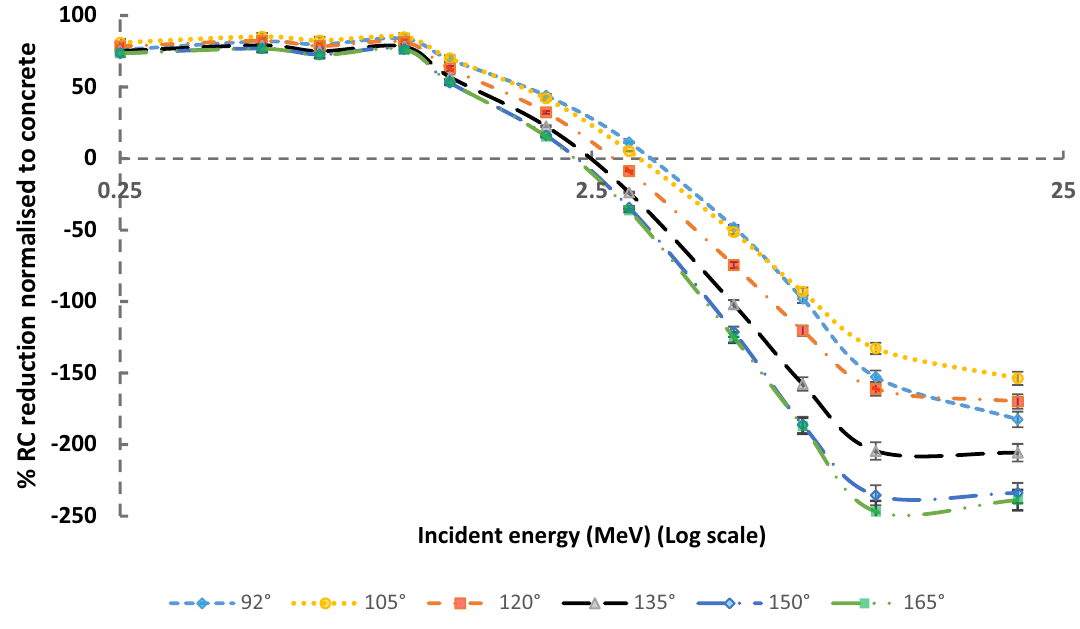
Figure 6. The percentage reduction factors of reflection coefficient (% RC) normalised to ordinary concrete for 2 mm Pb covering the ordinary concrete as a function of incident photons energy for variance reflection